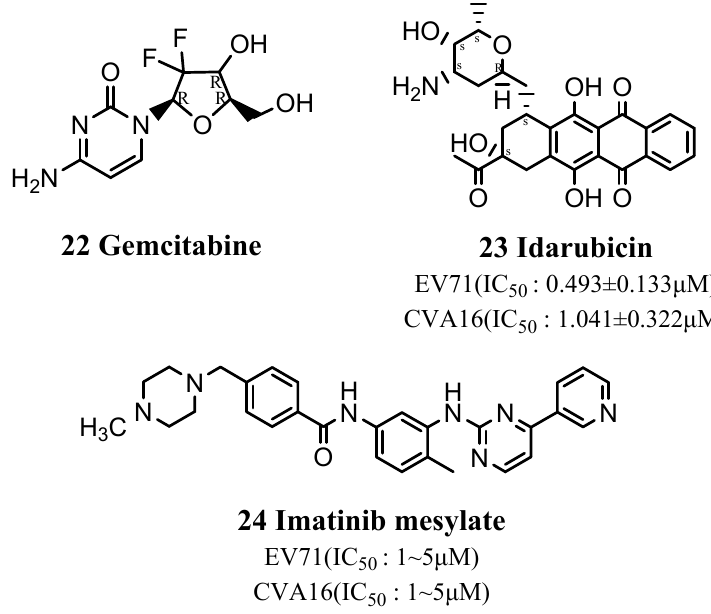
Figure 6. Structures of anticancer drugs.